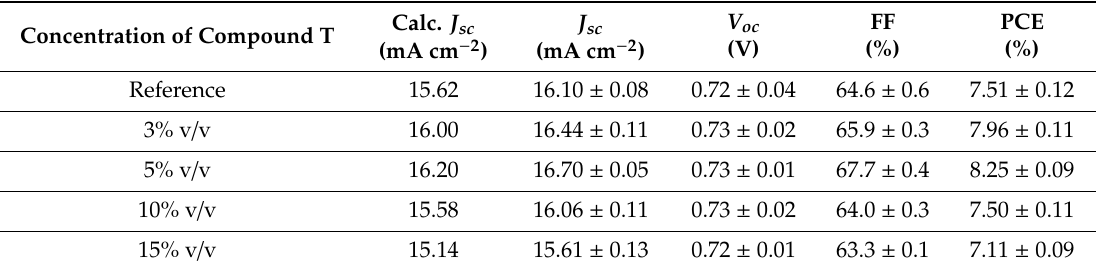
Table 1. Summary of solar cell parameters of PTB7:PC 71 BM and ternary PTB7:compound T:PC 71 BM blend with different concentrations *.